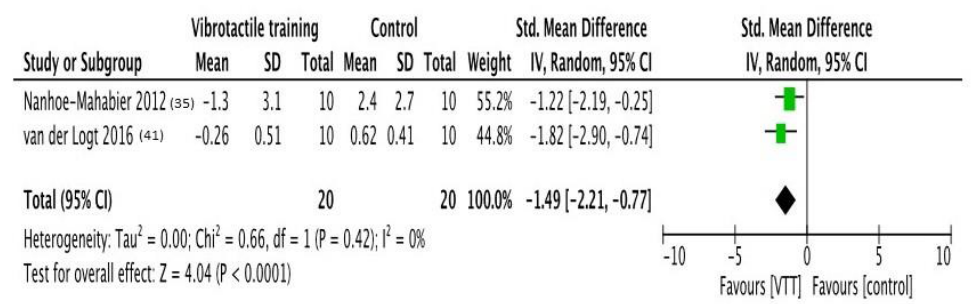
Figure 3. Forest plot of comparison: Overall effect of Vibrotactile feedback training in comparison to no-feedback interventions. Outcome: pitch sway angle. Abbreviations: VTT, vibrotactile training; CI, confidence interval; SD, standard deviation [35,41].